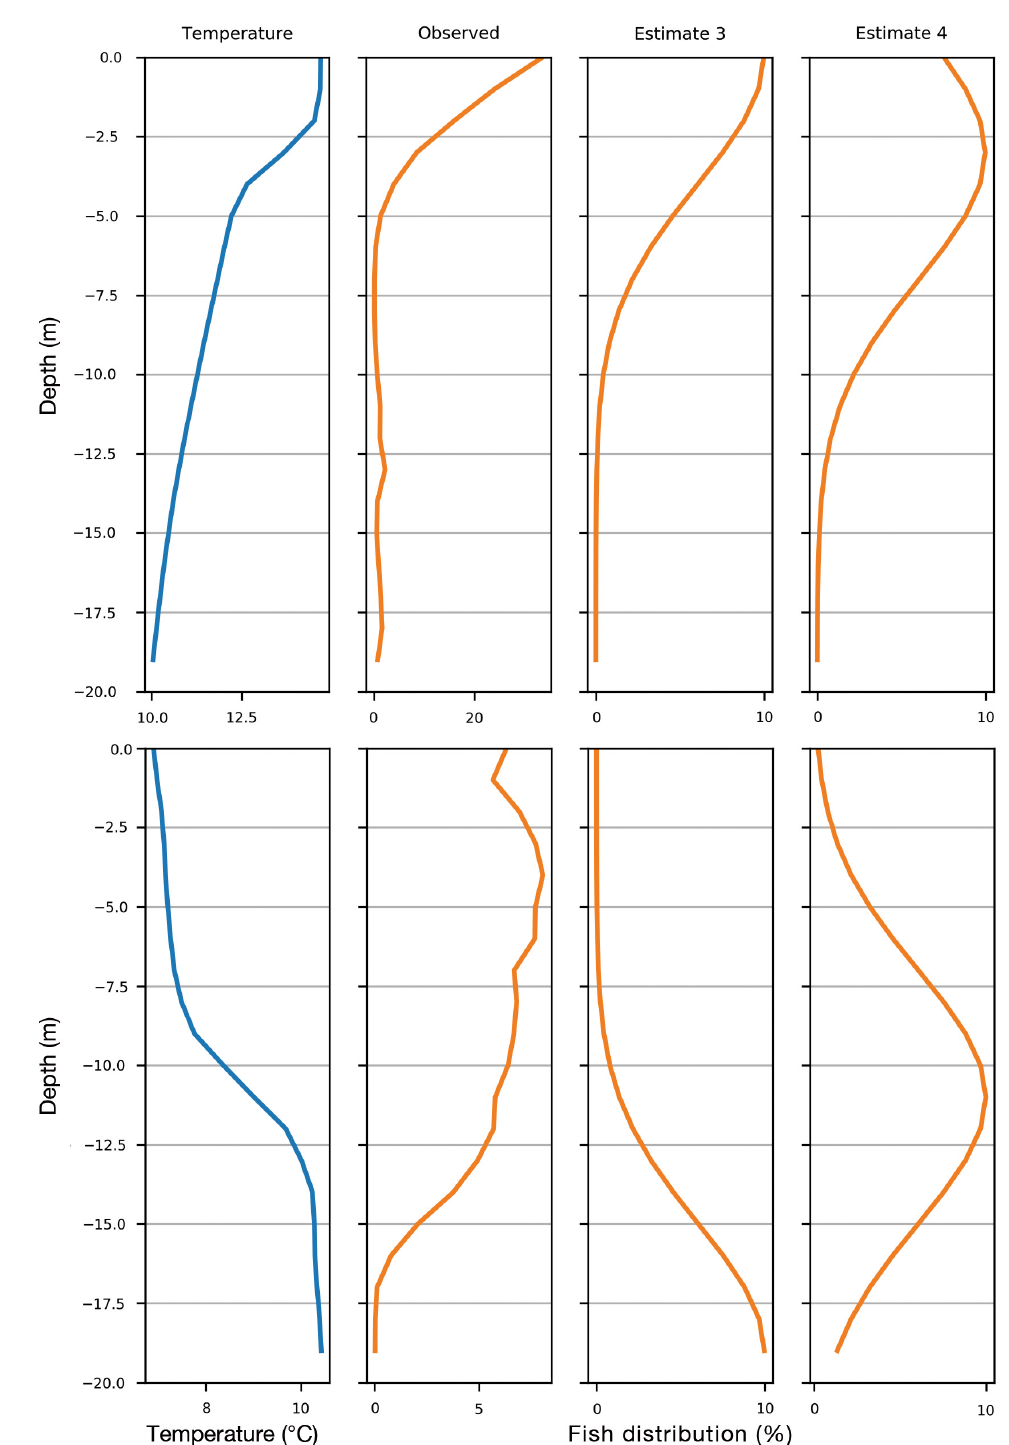
Fig. 6. Modelled vertical temperature gradient from Langavika on 1 July (upper panel) and 1 December (lower panel), observed vertical distribution of salmon and modelled fish distribution from Estimates 3 and